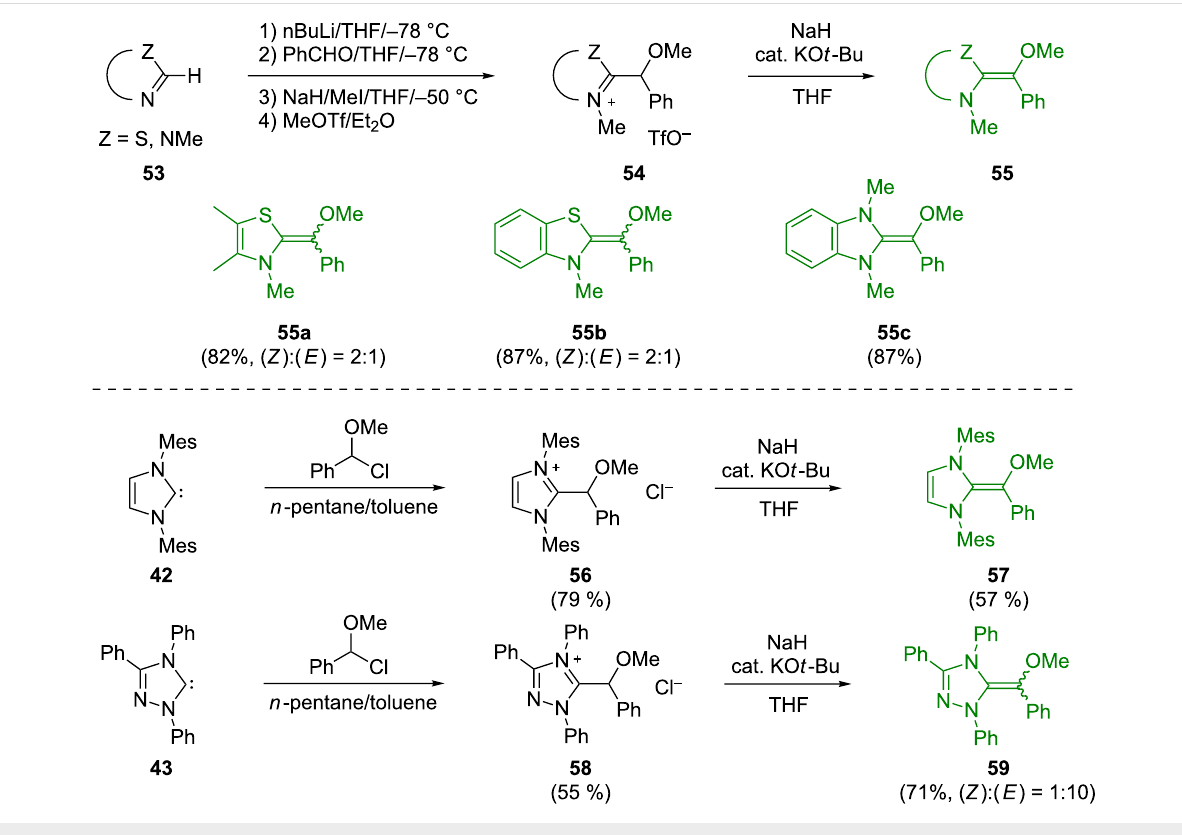
Figure 27: Synthesis of O-methylated Breslow intermediates [114].